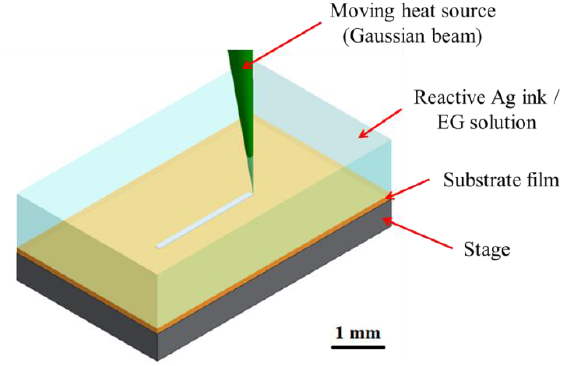
Figure 3. A schematic of the simulation domain used in the current